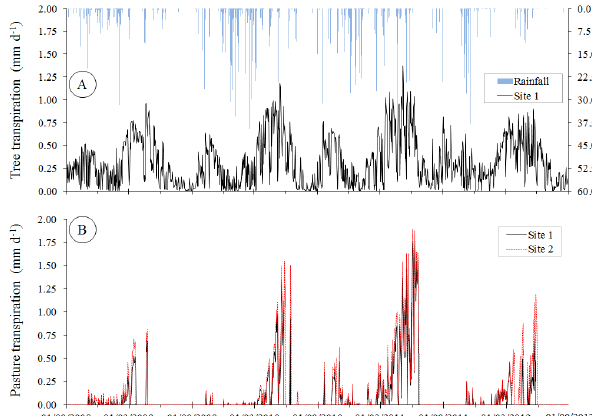
and B) natural pastures in Site 1 and Site 2 .